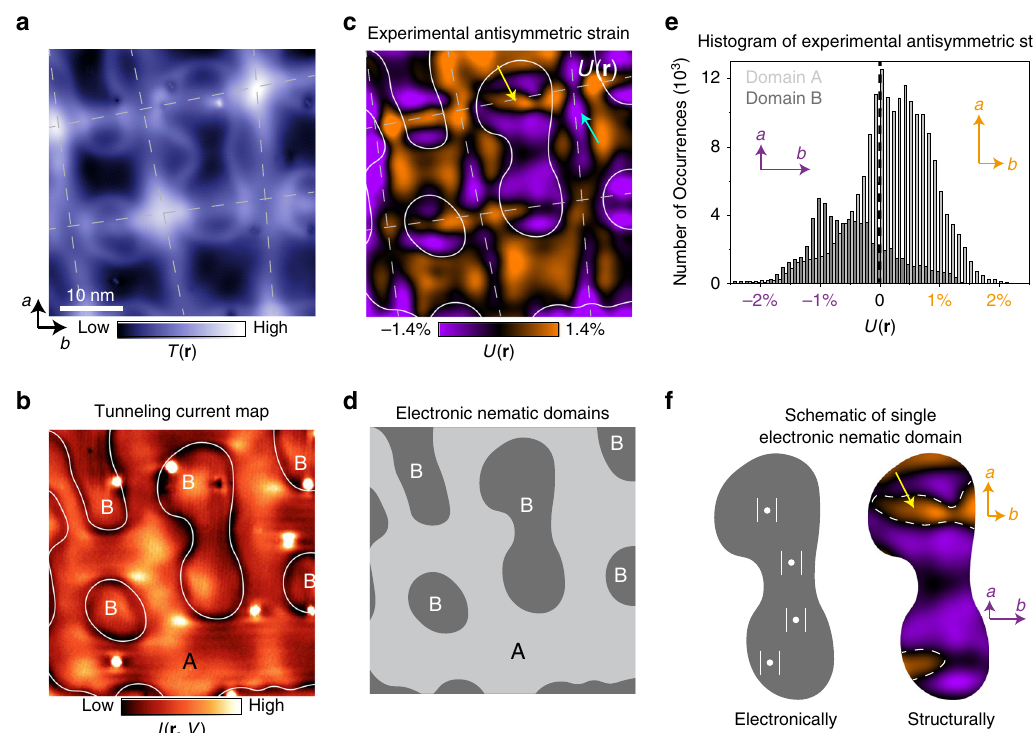
Fig. 4 Interplay of electronic nematicity and local strain. a STM topograph T ( r ), and b tunneling current map I ( r , V = 60 mV) acquired over an identical region of the sample. Dashed lines in a , c denote the network of structural modulations. Solid lines in b , c outline the electronic nematic domain boundaries. c The antisymmetric strain map U ( r ) calculated from a . d A schematic of electronic nematic domains determined from b , where A and B refer to orthogonal electronic nematic domains. e Histogram of the antisymmetric strain magnitude in electronic nematic domains A and B in c . f Magni fi cation of a single nematic domain B and the antisymmetric strain distribution within it. White dots and double lines depict the Fe impurities and electronic stripes associated with the direction of electronic nematicity. Dashed lines in f denote the borders between regions of positive and negative antisymmetric strain. STM setup condition: a I set = 110 pA, V sample = − 100 mV; b I set = 110 pA, V sample = − 100